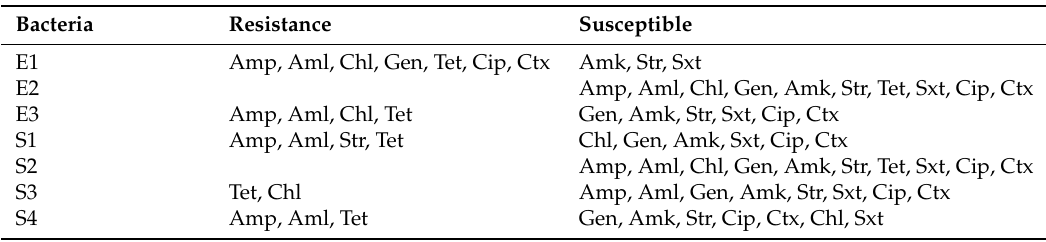
Table 1. Antibiogram of E. coli and Salmonella isolates.